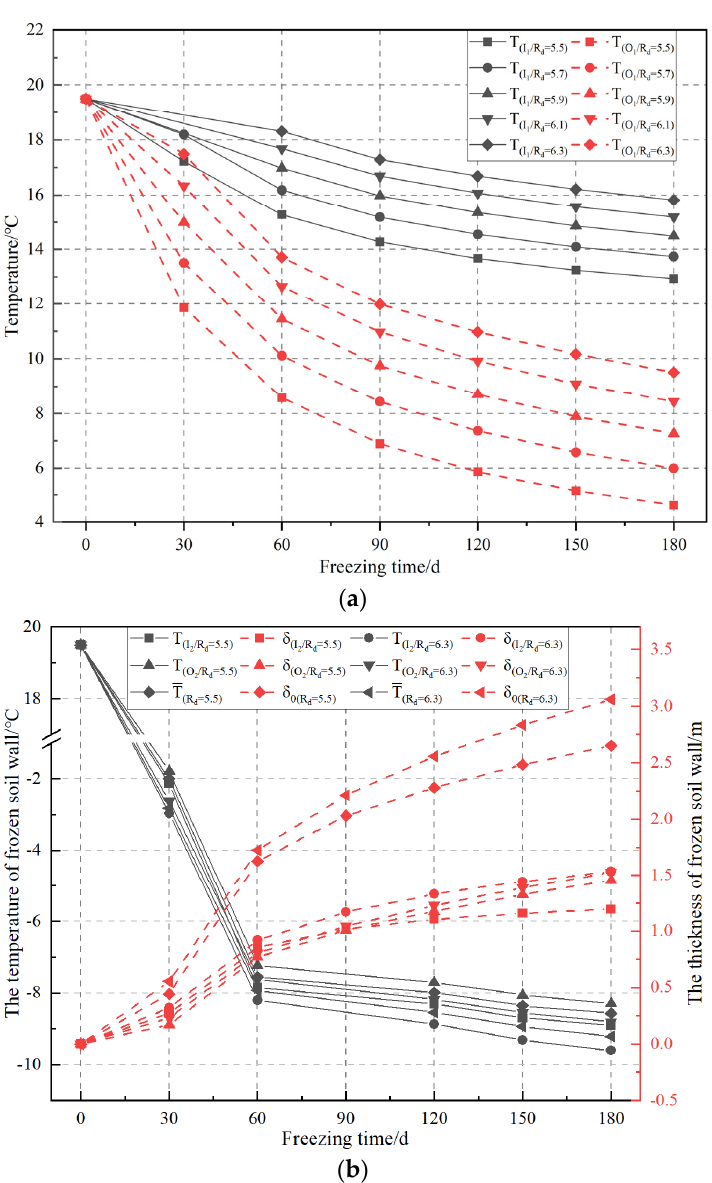
Figure 10. Variance in temperature and thickness under different layout radii of freezing tube and freezing time: ( a ) temperature in interlayer and outside wall of shaft, ( b ) temperature and thickness in the inside and outside of frozen soil wall and its average or sum value with layout radii of 5.5 m and 6.3 m.